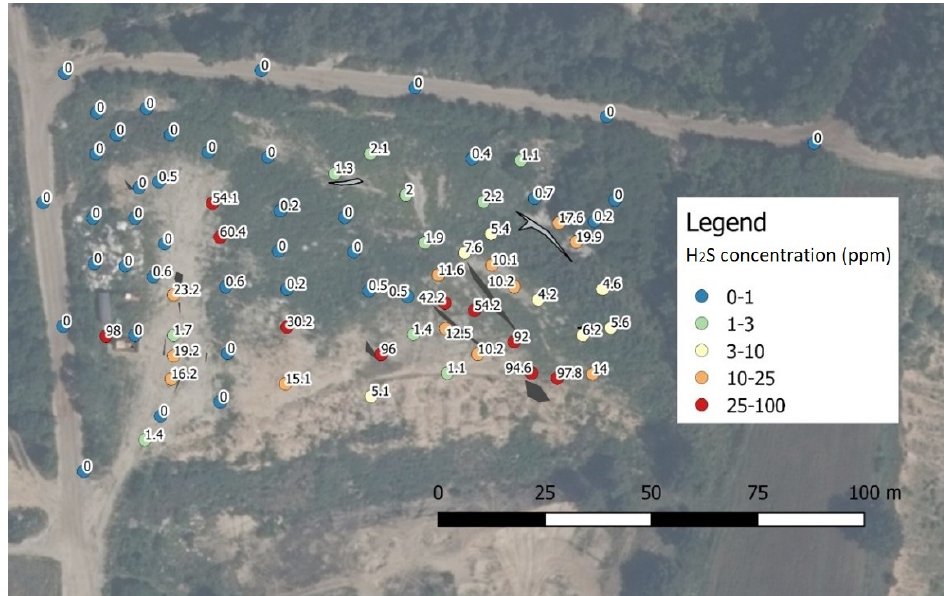
Figure 2. Spatial distribution of hydrogen sulphide concentration in series 2.